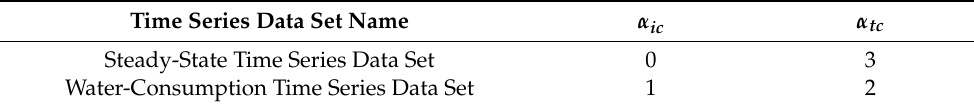
Table 3. Threshold coefficients in two time series data